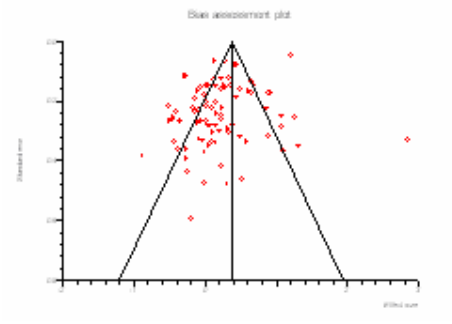
Figure 2. Bias Assessment